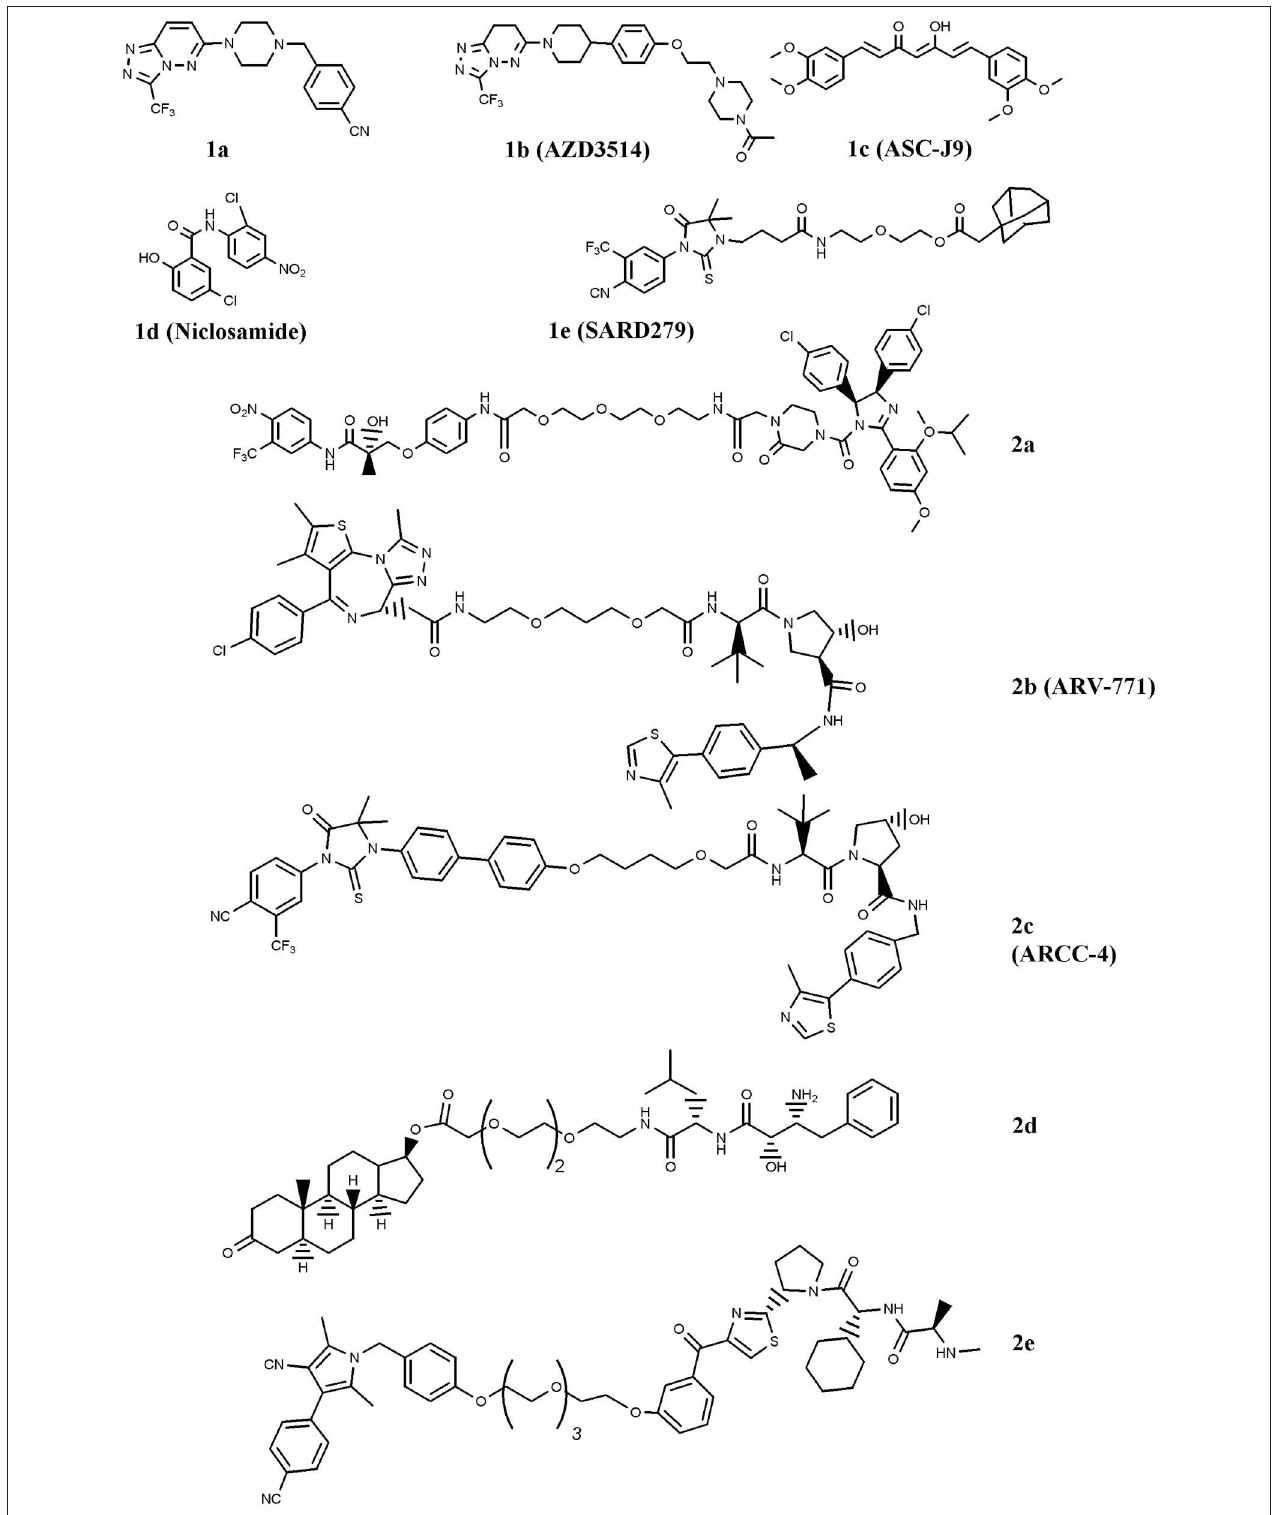
FIGURE 1 | Chemical structures of AR-ligand based conjugates that reduce AR expression. The chemical structures of Selective AR degraders (SARD, 1a–e ) and PROteolysis TArgeting Chimeras (PROTAC, 2a–e ) are reported.